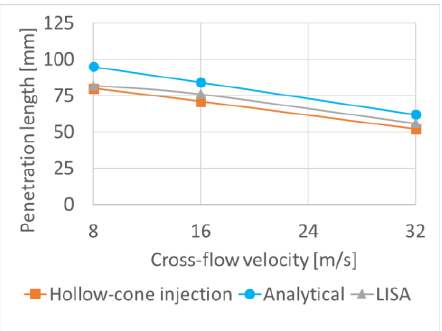
Fig. 12 Comparison of penetration length for different cross-flow velocities and different numerical approaches for 60 µm droplet